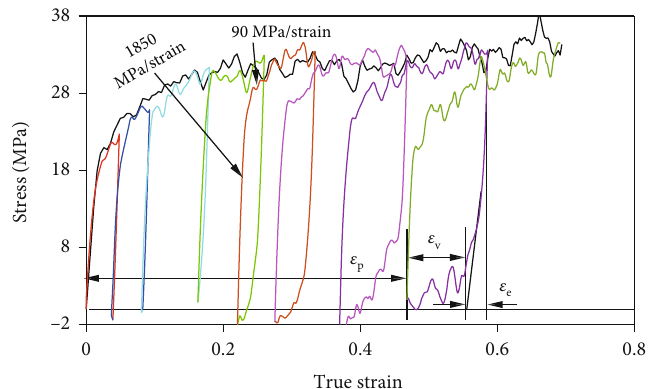
Figure 9: The stress-strain curve of the coarse-grained PU matrix under successive cyclic tensile loading (the colored one). The stress-strain curve under tensile was also drawn as the black one for comparison. The strain rate is 5 × 10 10 /s.